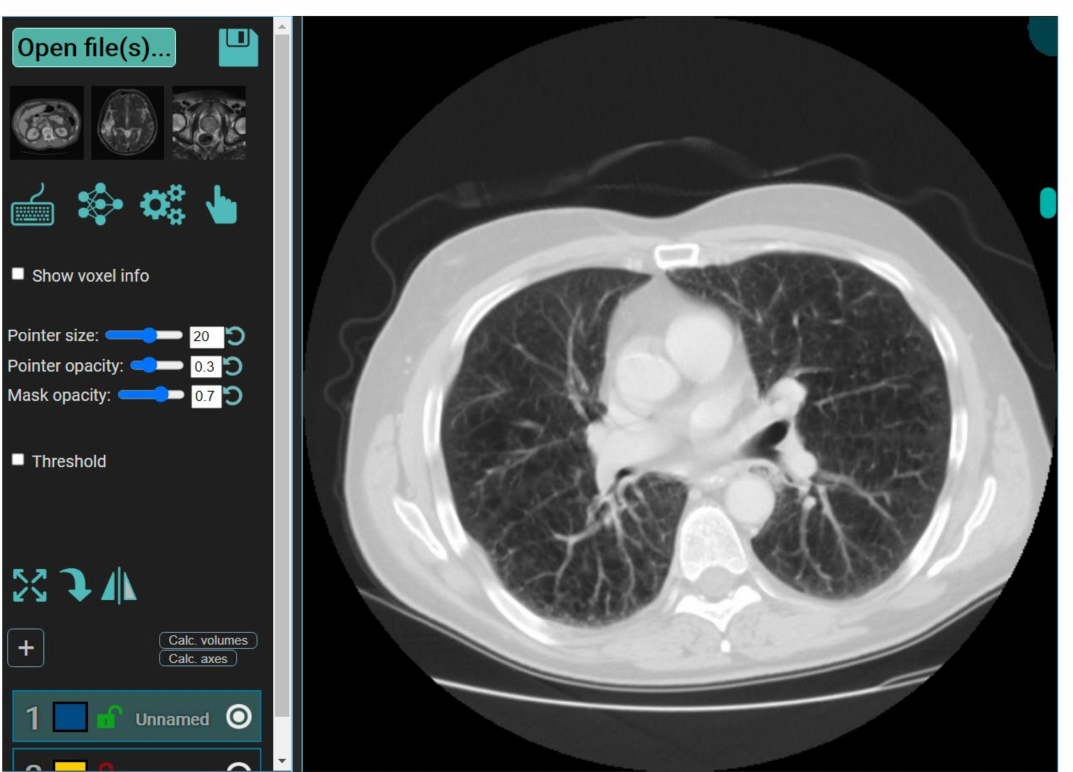
Figure 7. Display of CT image using the MedSeg